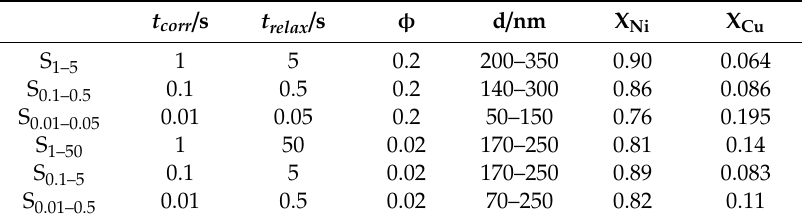
Table 1. Range of diameters d (nm) and molar fractions of Cu and Ni (X Cu and X Ni ) of porous nickel electrodes prepared using di ff erent t corr and t relax during the anodic pulsed voltage dissolution